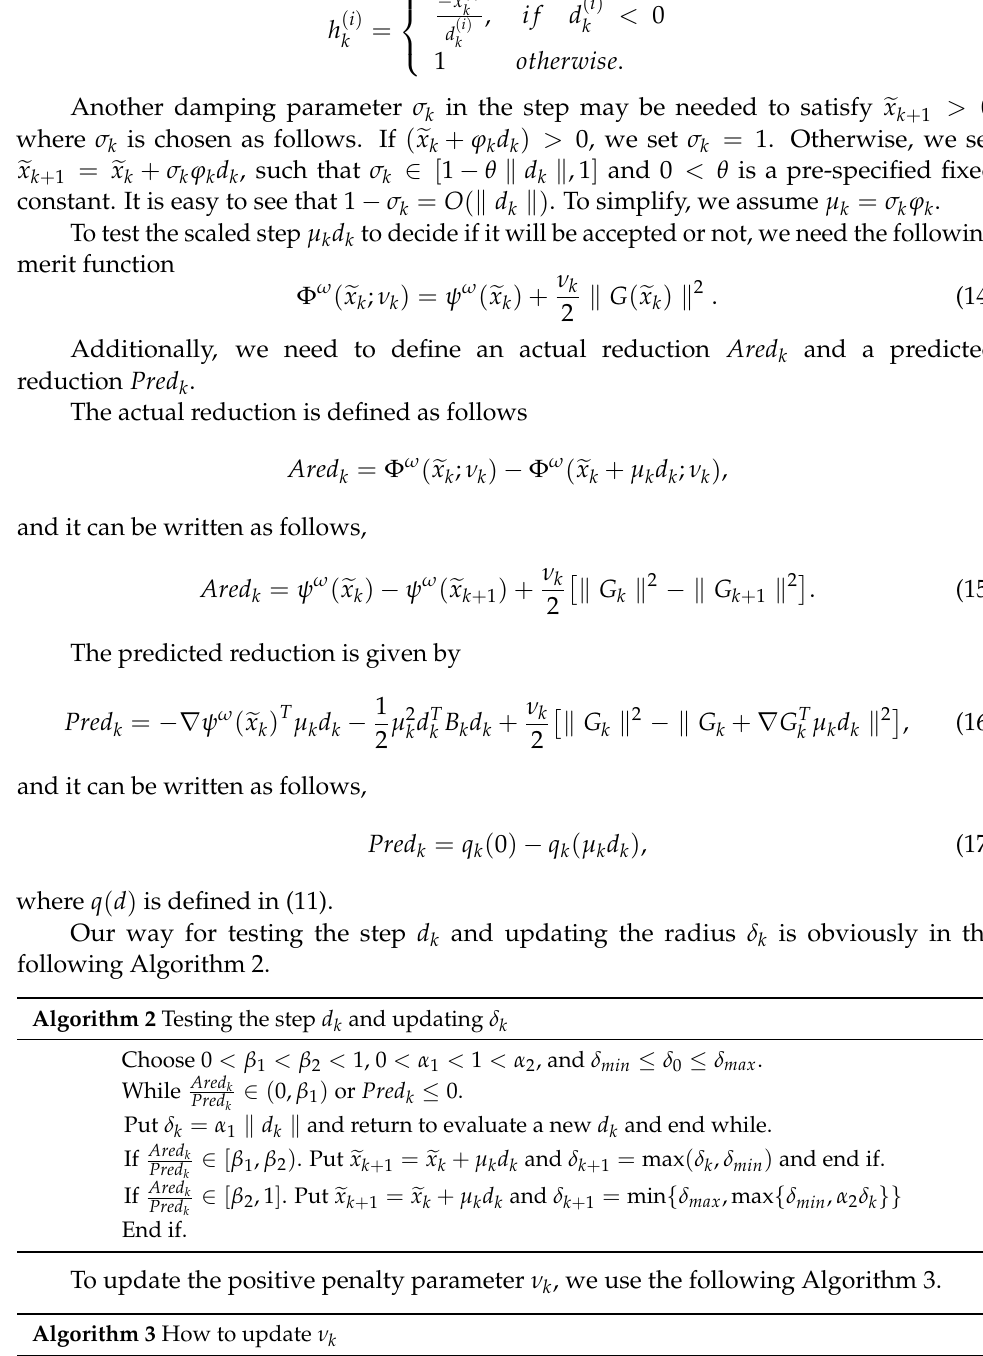
Algorithm 3 How to update ν